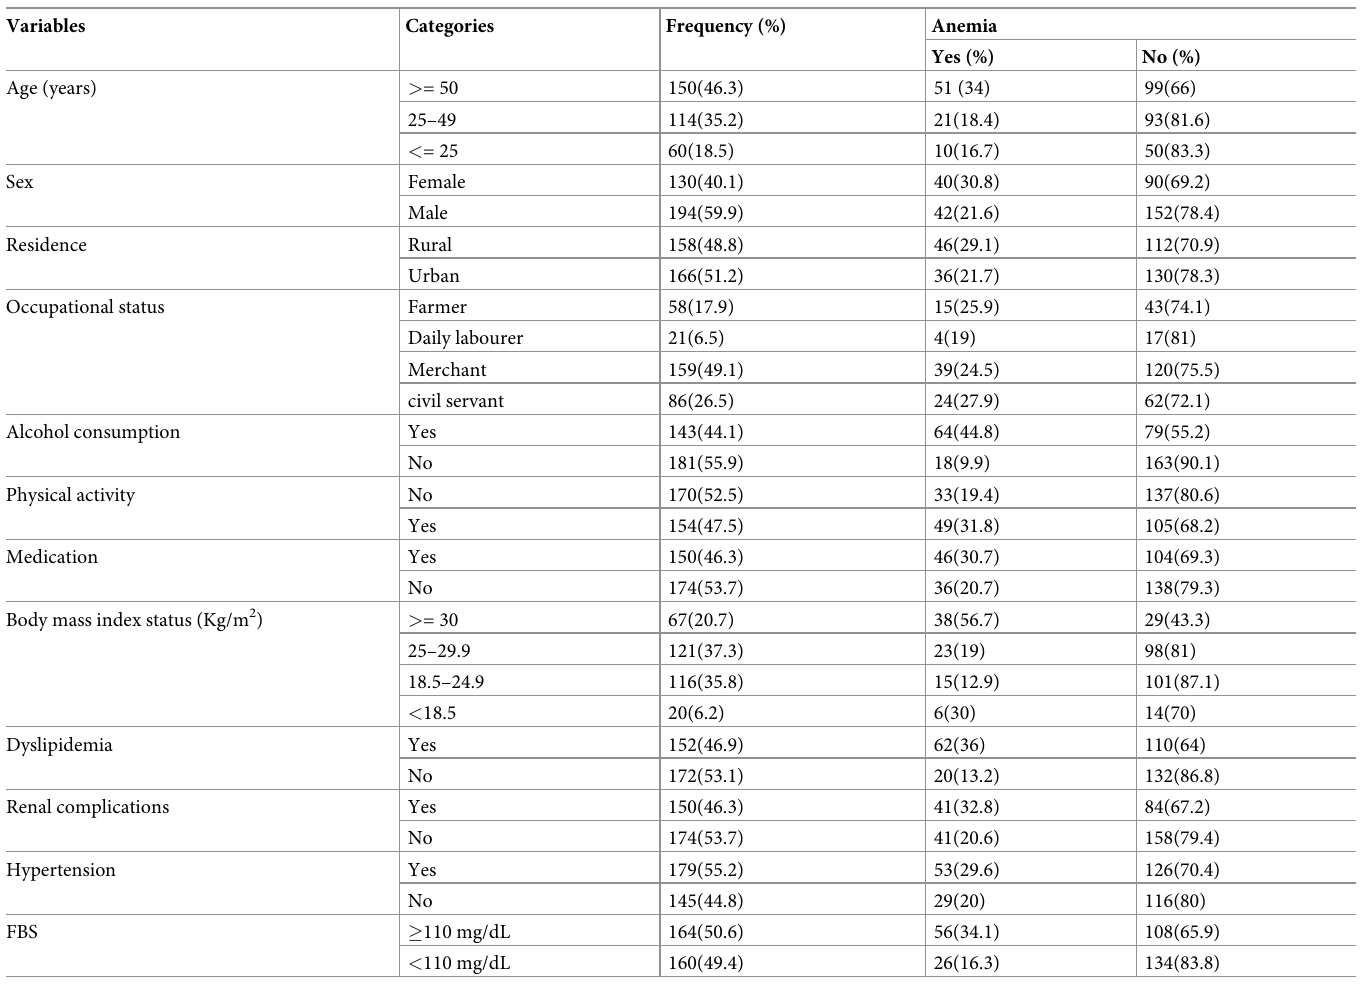
Table 1. Distribution of socio-demographic and clinical characteristics of study participants (n =